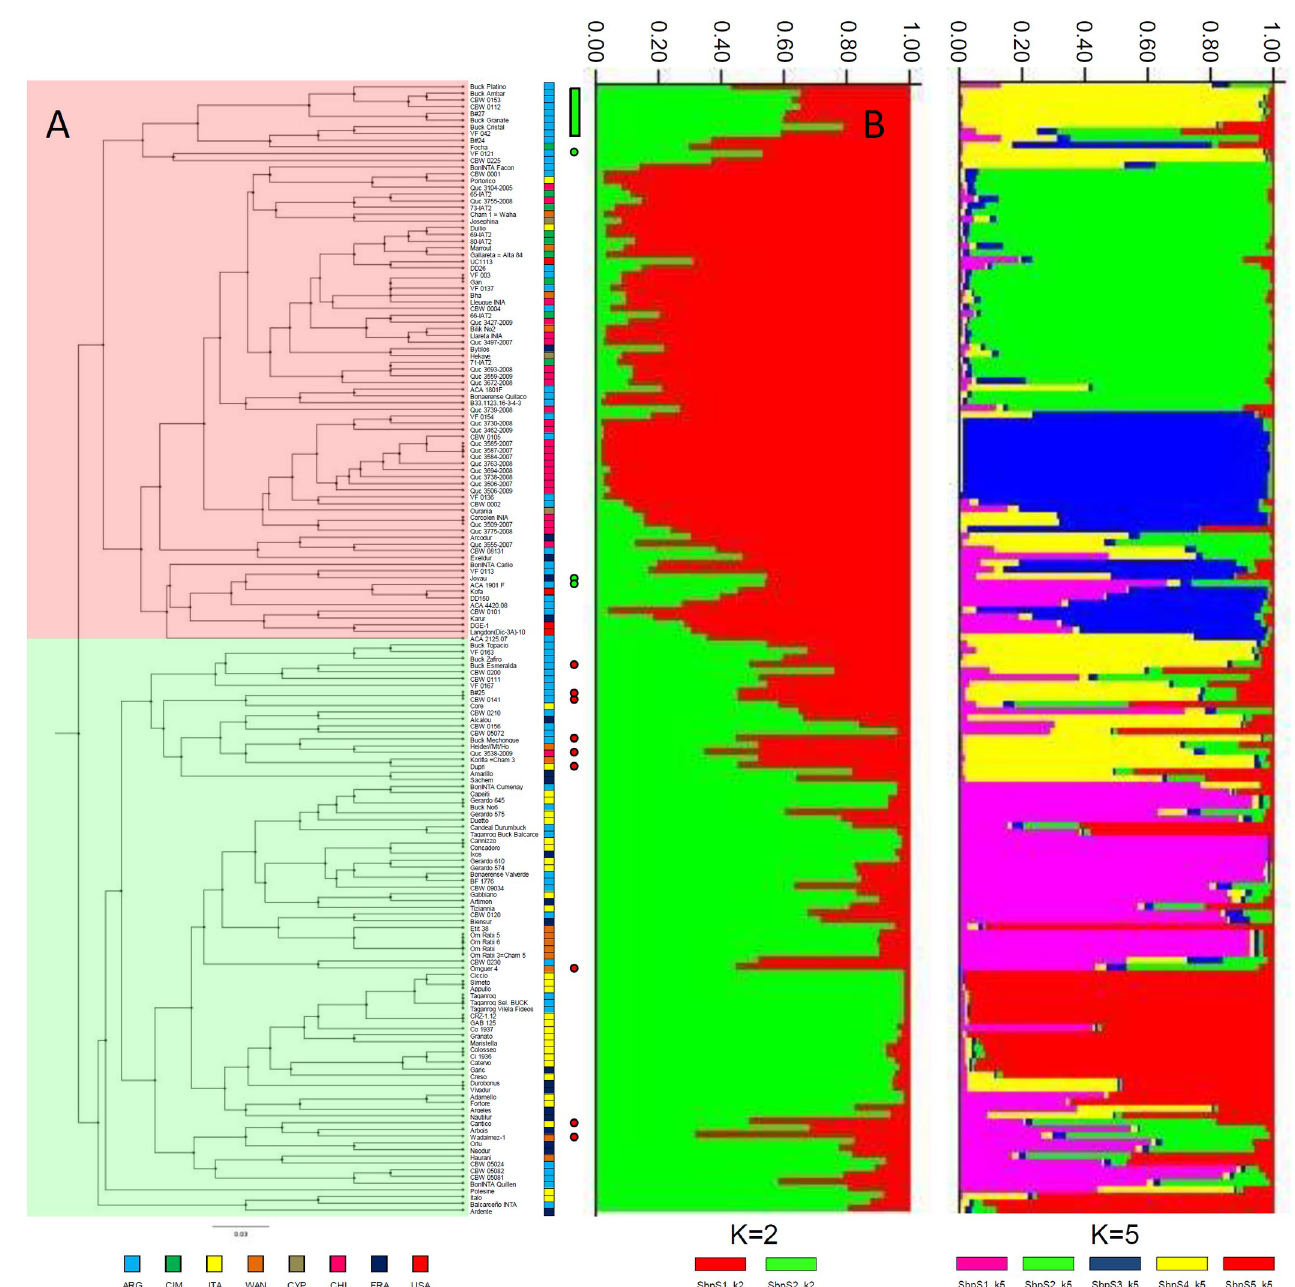
Fig 1. Comparison of population structure obtained by UPGMA cluster analysis and a Bayesian model (STRUCTURE) using SNP markers in the whole durum wheat collection. (A) Circles or bars colored in green and red indicates the accessions with differences in the subpopulation assigned by UPGMA and STRUCTURE analyses. The country of origin of accessions is indicated by colored squares in front of the name of accessions. (B) Results for K = 2 and K = 5 obtained by STRUCTURE.